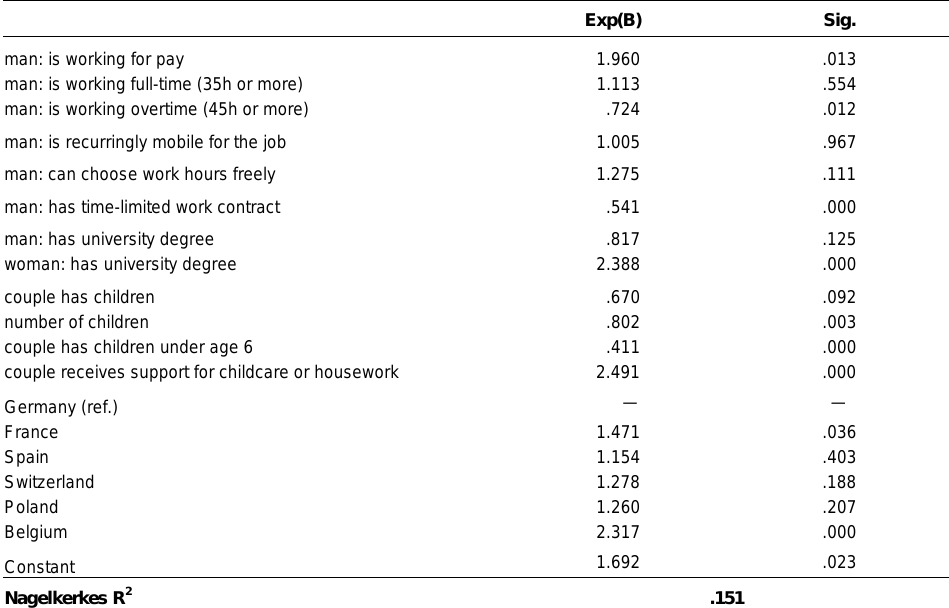
Table 2 : Circumstances fostering partnered women’s paid work (logistic regression) Exp(B)